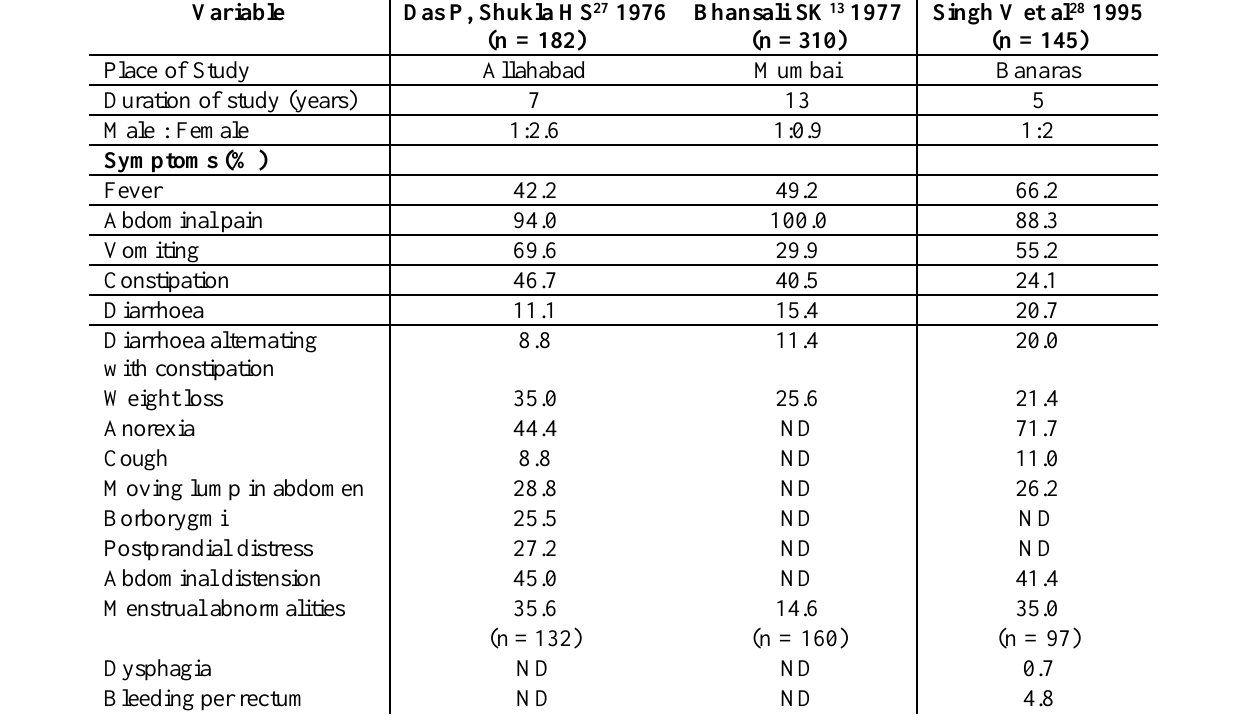
Table I : Demogrophic characteristics and symptoms at presentation in Indian patients with abdominal